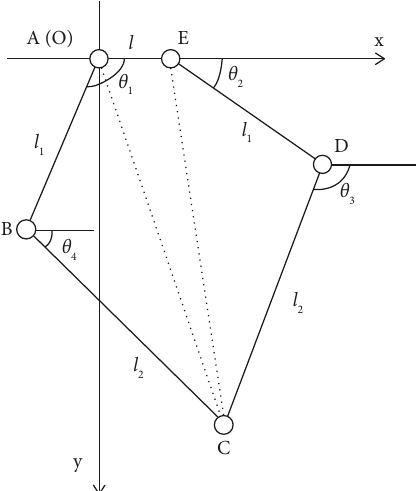
Figure 6: The schematic diagram of joint coordinates of parallel leg